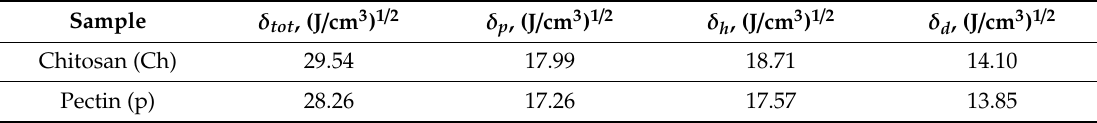
Table 1. Values of theoretical calculated solubility parameters of chitosan (Ch) and pectin (P).